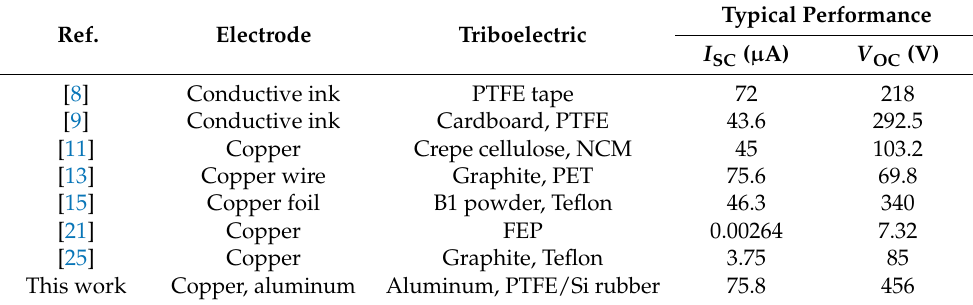
Table 1. Comparison of existing triboelectric nanogenerators using paper. Ref.